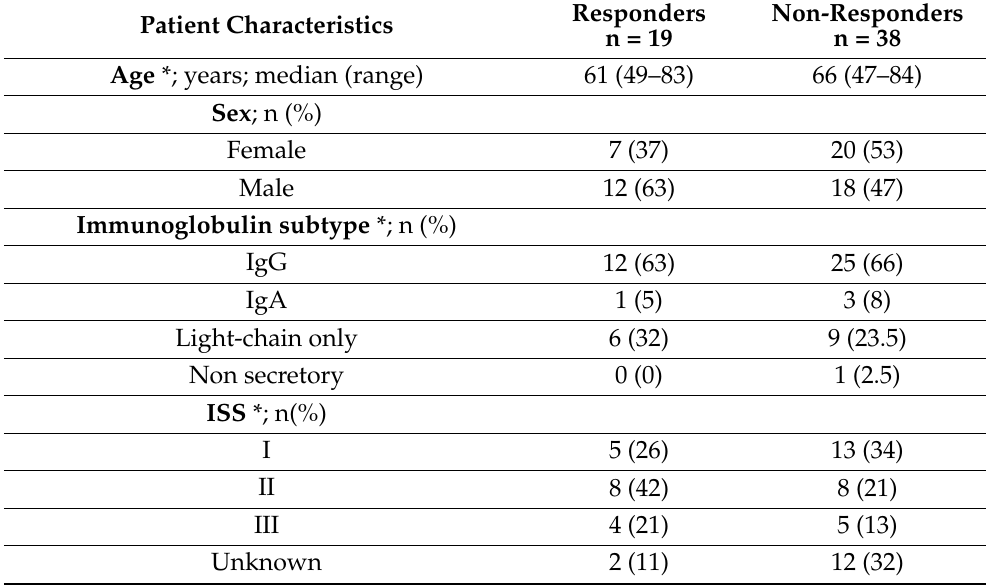
Table 1. Patient